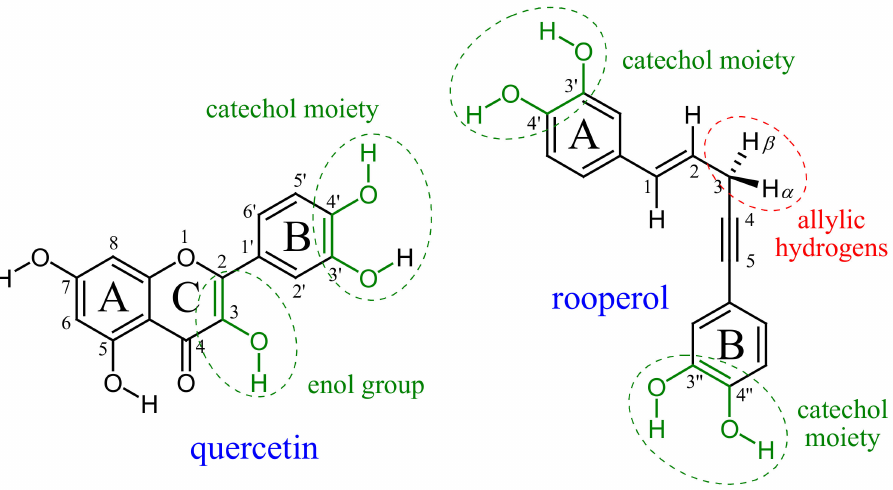
Figure 1. Structure, atom numbering and antiradical moieties (in green) of quercetin and